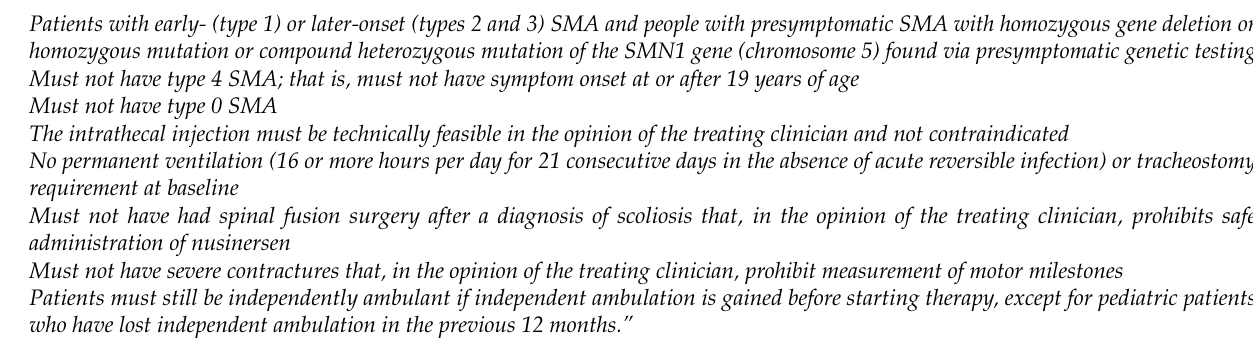
Table 1. Shows the eligibility criteria for nusinersen treatment—adopted from UK’s NICE guide- lines